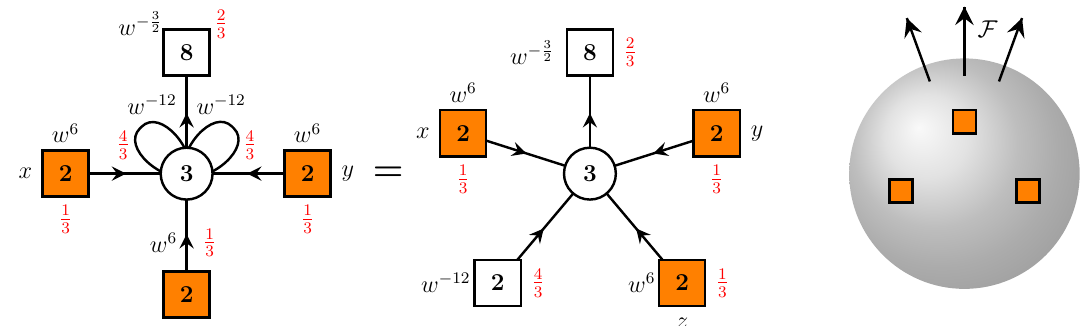
Figure 9: Quiver of the C trinion theory. It is obtained taking N = 1 in the theory 1 presented on the Figure 21 and corresponds to a three punctured sphere compacti- fication of the E-string theory such that all the punctures are of the same type and the flux breaks E to SU ( 8 ) × U ( 1 ) . The line starting and ending on the SU ( 3 ) node 8 denotes a field in antisymmetric two index representation which is the same here as fundamental representation. The SU ( 2 ) symmetry rotating the two fields in the symmetric representation is broken by a